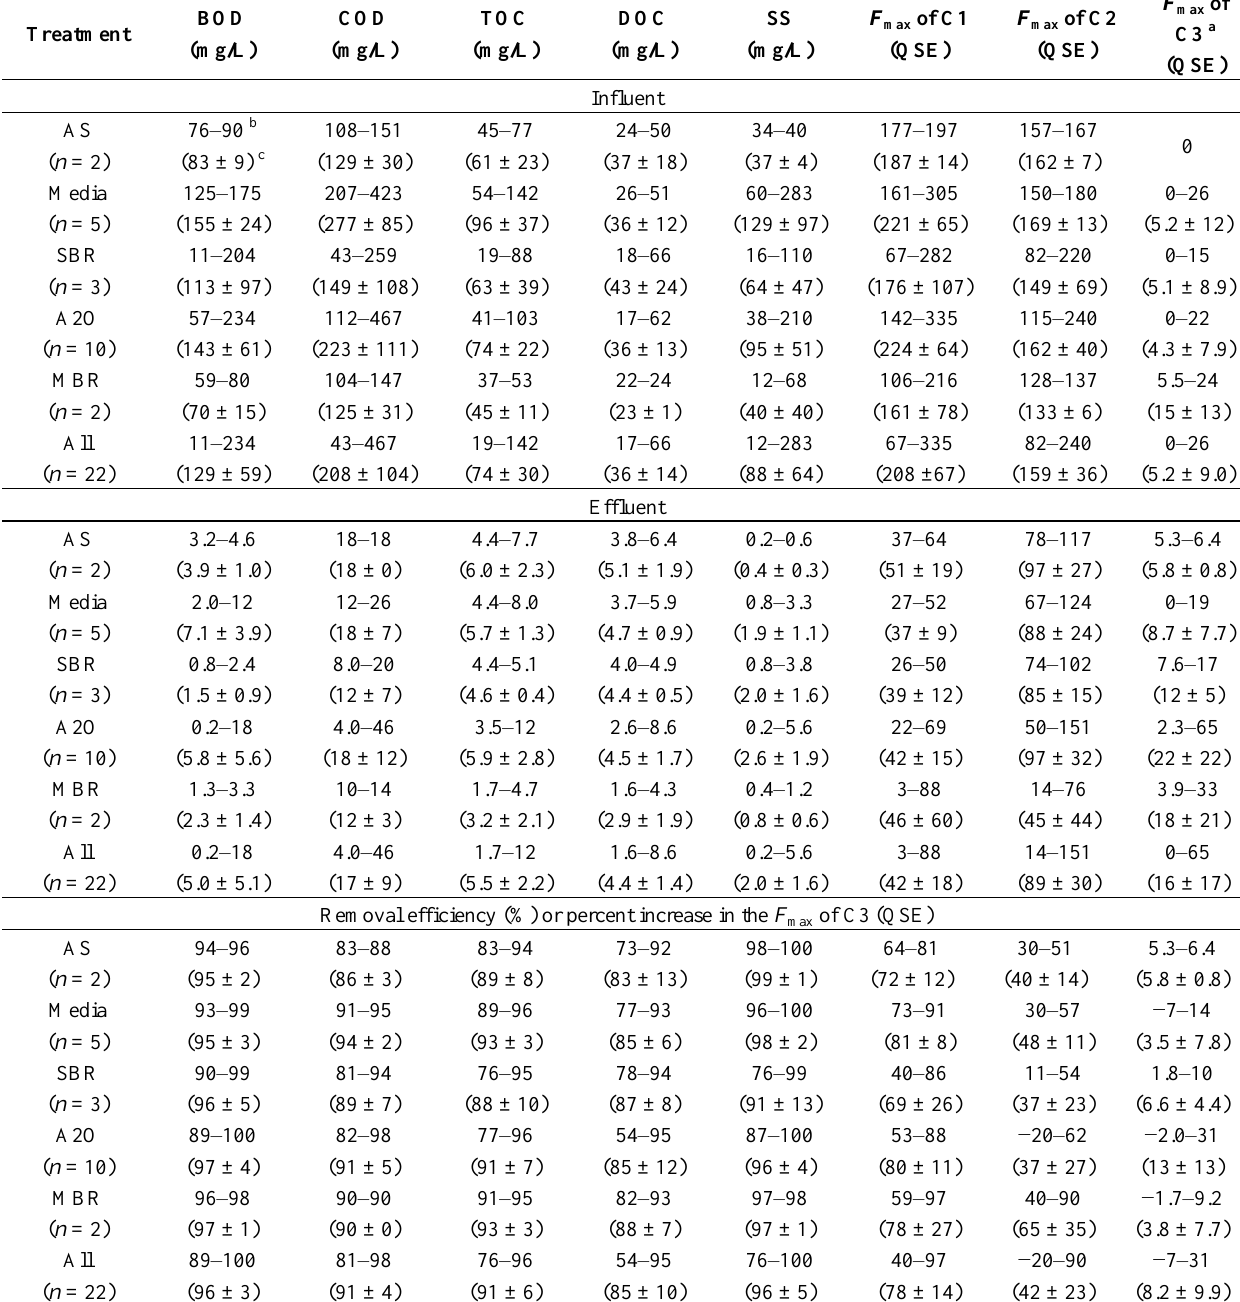
Table 1. Summary of BOD, COD, TOC, DOC, SS, and fluorescence intensities of C1, C2, and C3 in the influents and effluents, and the relative changes (%) in the five types of treatment